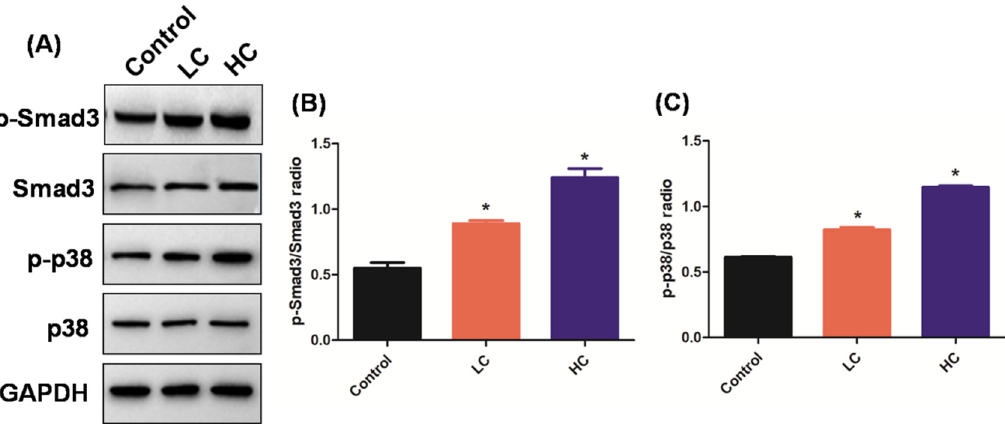
Figure 3. OMPM exposure induced PF via the TGF- β 1/Smad3 and TGF- β 1/p38 MAPK signaling pathways in rat lung tissues. ( A ) The phosphorylation of Smad3 and p38 after OMPM exposure detected with Western blotting; ( B ) ratio of p-Smad3/Smad3; ( C ) ratio of p-p38/p38. Data represent mean ± SD. * p < 0.05 vs. the control group.